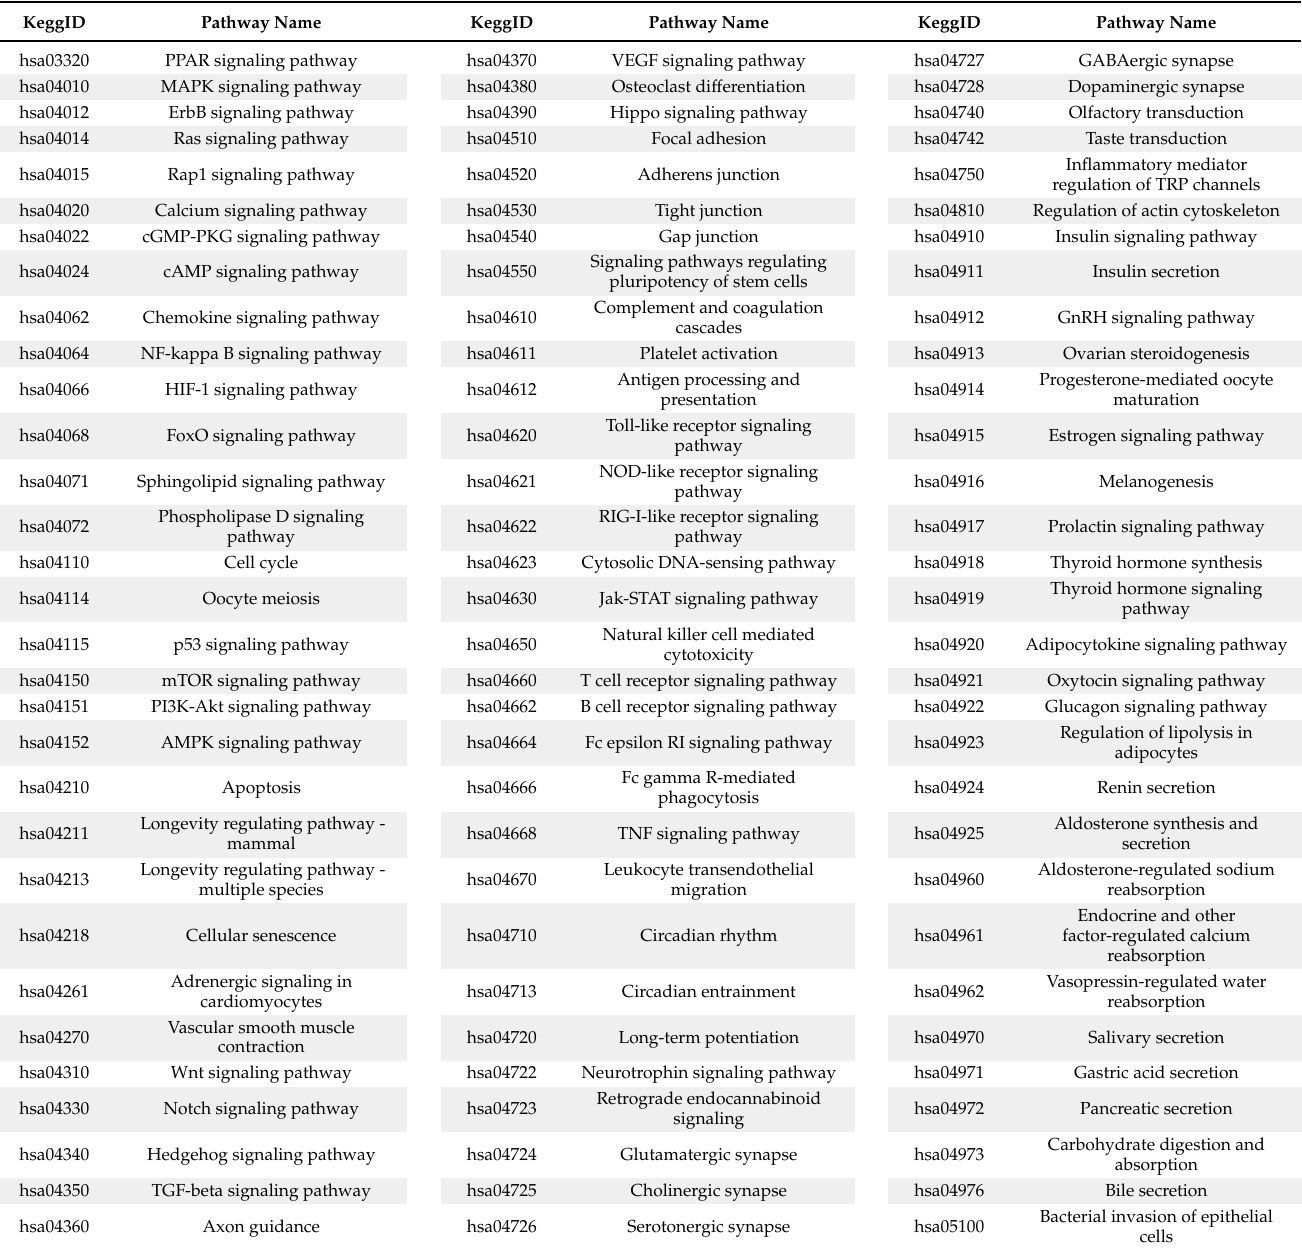
Table A1. List of pathways used as the sources for the circuit decomposition to encode the prior knowledge of